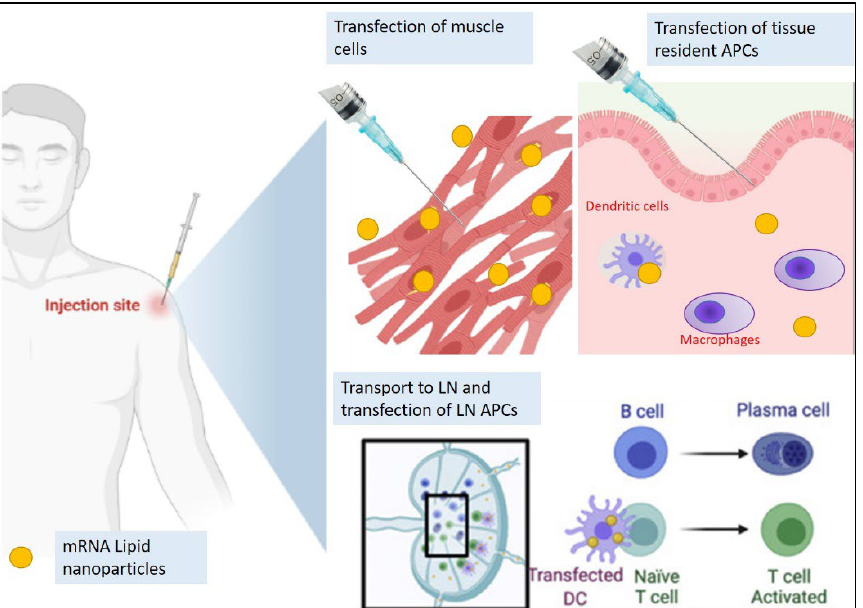
Figure 2. mRNA lipid nanoparticles’ (mRNA-LNPs) site of intramuscular administration and modes of action of the mRNA-LNPs. mRNA-LNP vaccines can transfect muscle cells and transfect the tissue-resident antigen-presenting cells (APCs) near the injection site. Additionally, mRNA-LNP vaccines can flow into lymph nodes (LNs) and transfect the LN-resident cells, resulting in activation of T and B cells. Adapted with permission from [25].